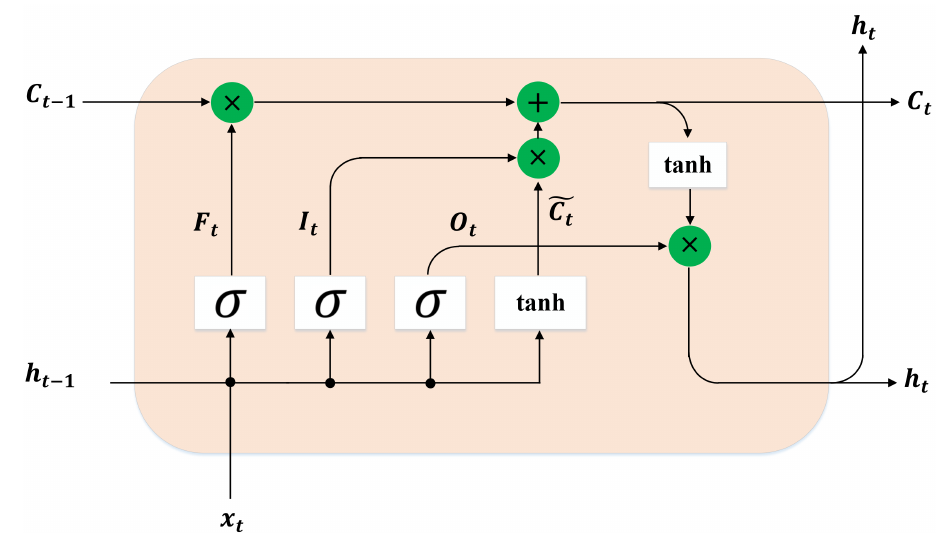
Figure 2. Schematic illustration of a convolutional long short-term memory (ConvLSTM) cell with all